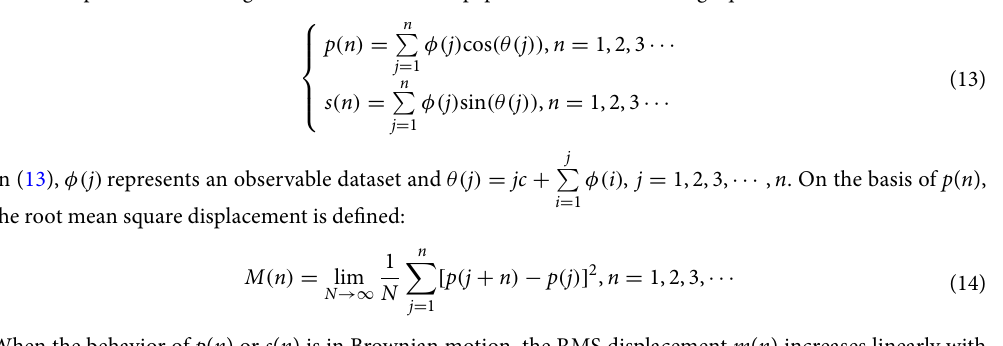
2 planes. ( a ) poincare section when i ( 3 ) = a k 4.5 . ( c ) poincare section when i ( 3 ) ( 3 ) = 3 and = = a k 4.5 ( 3 ) = 6 and = =